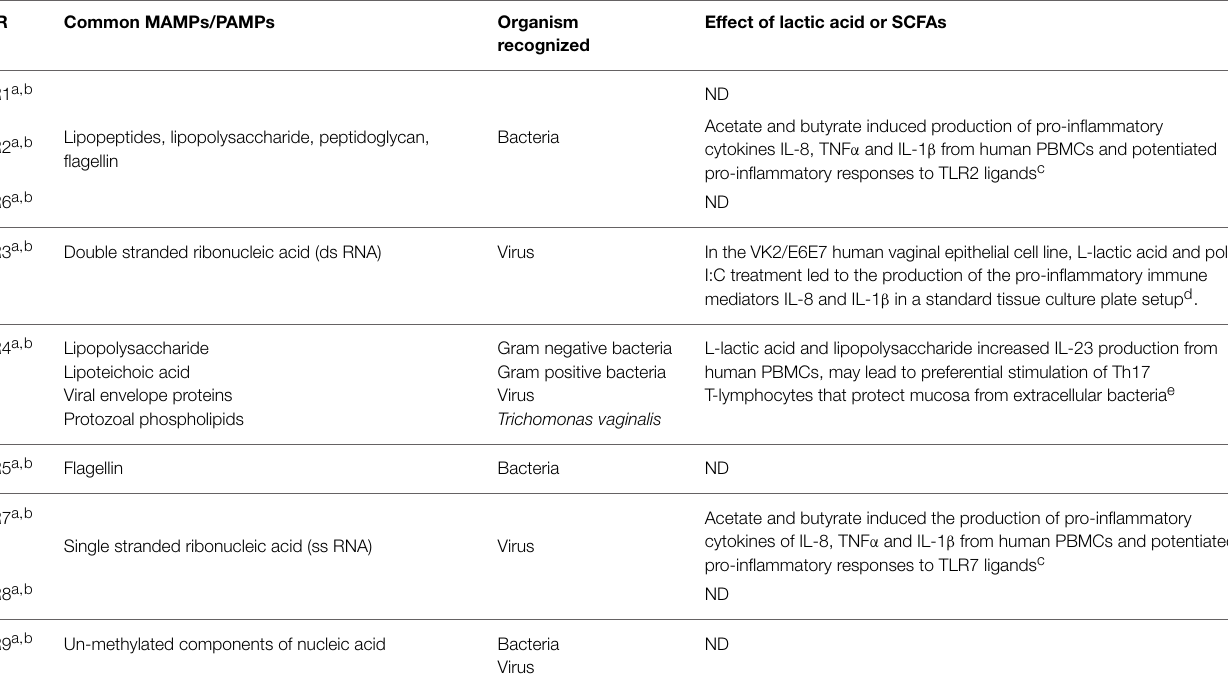
TABLE 2 | The effects of lactic acid and BV-associated SCFAs on TLR responses.